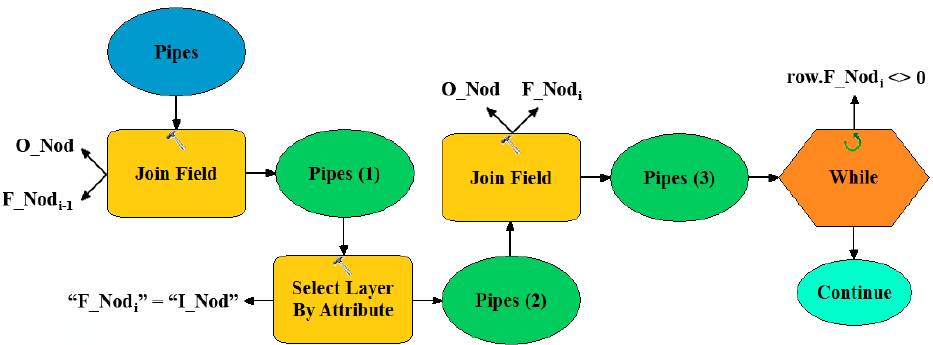
Figure 2. Workflow for the identification of the flood ‐ related nodes.